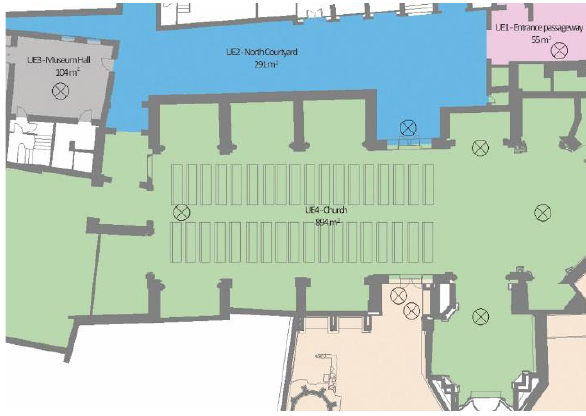
Figure 7. 2D plan of the Spatial